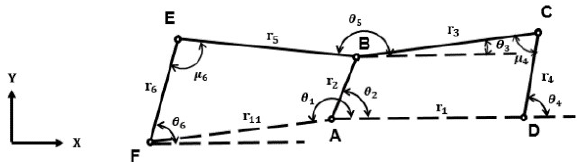
Figure 4. Structure of a center driven linkage system (CDLS).